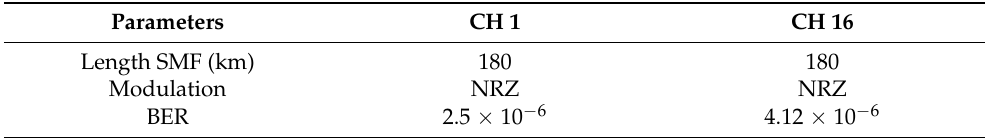
Table 5. Parameters and results of 16-channel DWDM [23].